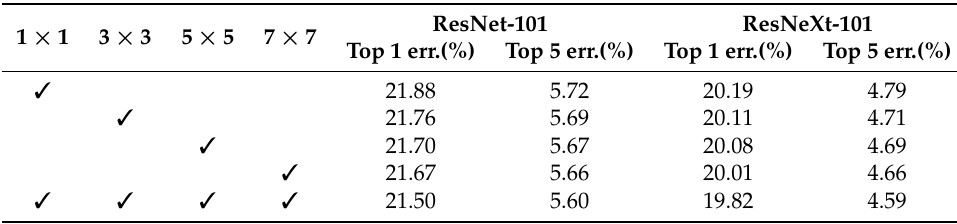
Table 6. Investigation on HGA